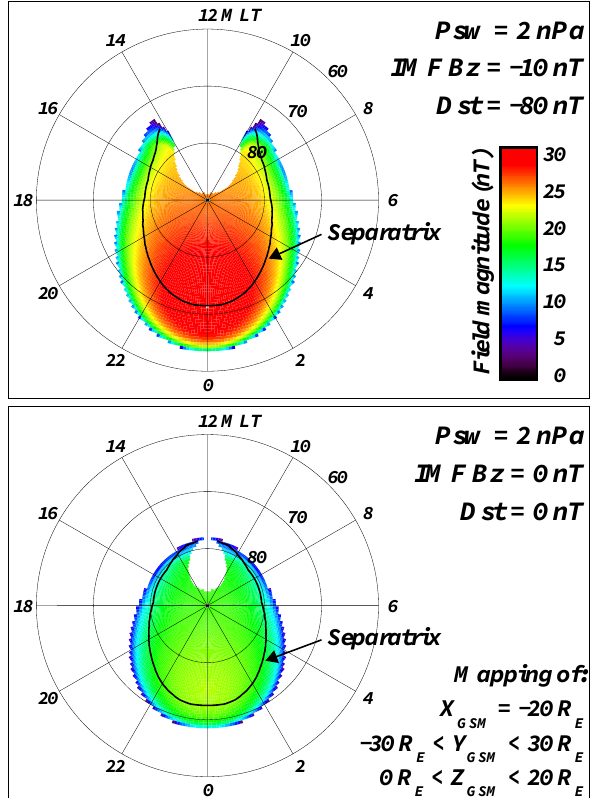
Fig. 9. Results of the Tsyganenko-96 geomagnetic field model for the two IMF cases prior to the pressure enhancement ( P sw = 2nPa), IMF strongly southward (top), and IMF B z = 0 (bottom). The color- coded images represent the mapping to the ionosphere of the total field magnitude in the tail ( X GSM =− 20 R E ), expressed in nT ac- cording to the color scale at the right. The solid black line gives the approximate location of the separatrix. The field strength in the top panel is 30% higher than that in the bottom panel, resulting in a more efficient reconnection enhancement after the pressure front impact, that leads to a more widespread shrinking of the polar